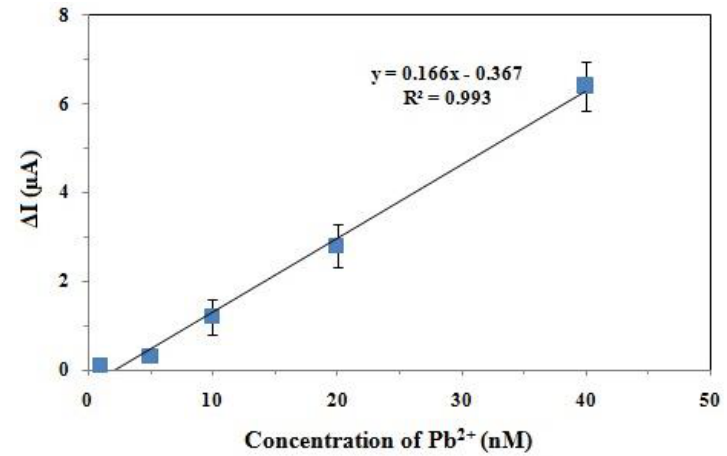
Fig. 3. The linear relationship between DPV peak current changes and Pb 2+ Figure 3. The linear relationship between DPV peak current changes and Pb 2+ concentration.